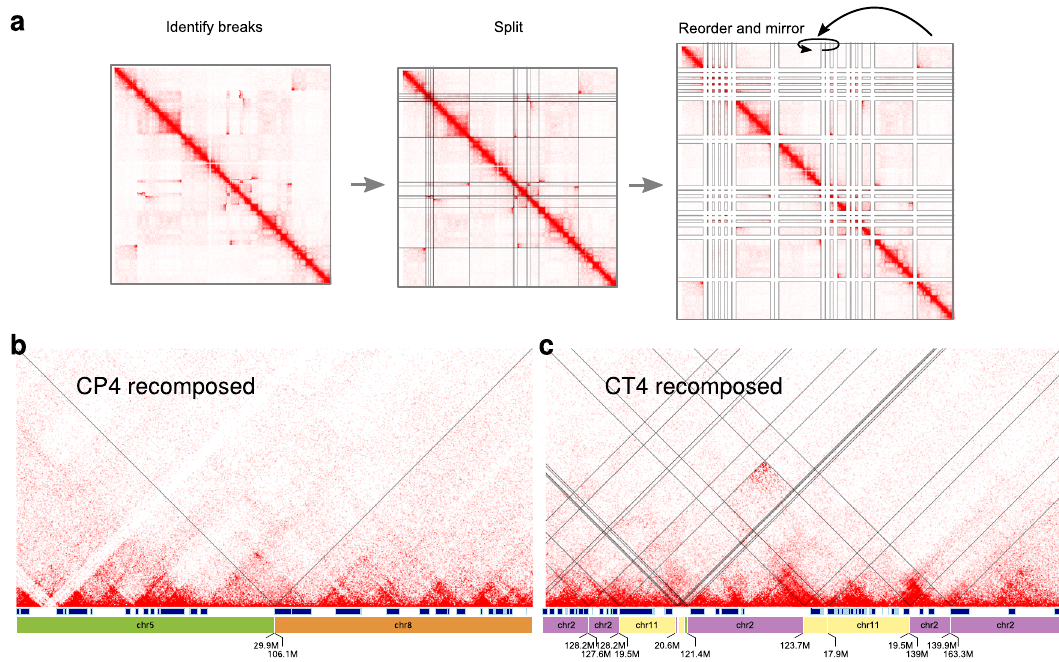
Fig. 5 | Analysis of the chromatin structure of reshuf fl ed chromosomes. a Recomposing of Hi-C maps by cutting a Hi-C mapatall breakpoint positions and reordering and reorienting all rows and columns according to the reconstruction scheme. b Recomposed Hi-C map for CP4 ( c ) and CT4. Labels for small